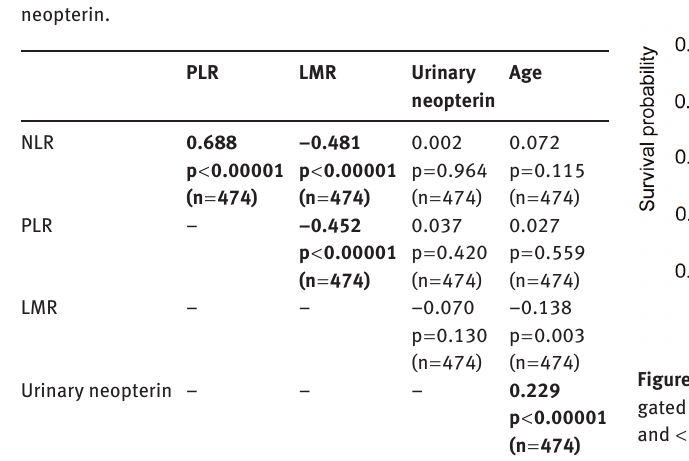
Table 3: Correlation between PBC-derived ratios and urinary